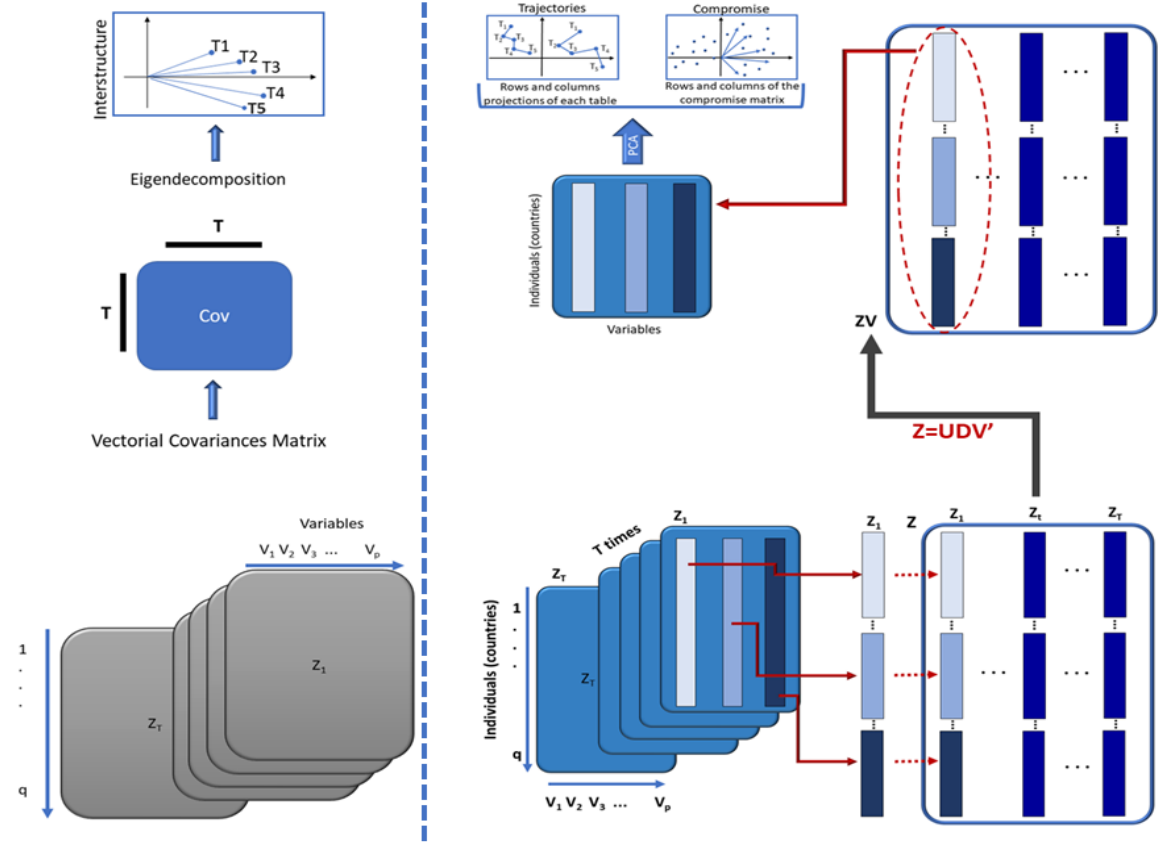
Figure 2. Scheme of the X-STATIS or PTA Method. Reprinted/adapted with permission from Ref. [52]. 2017 , Springer.